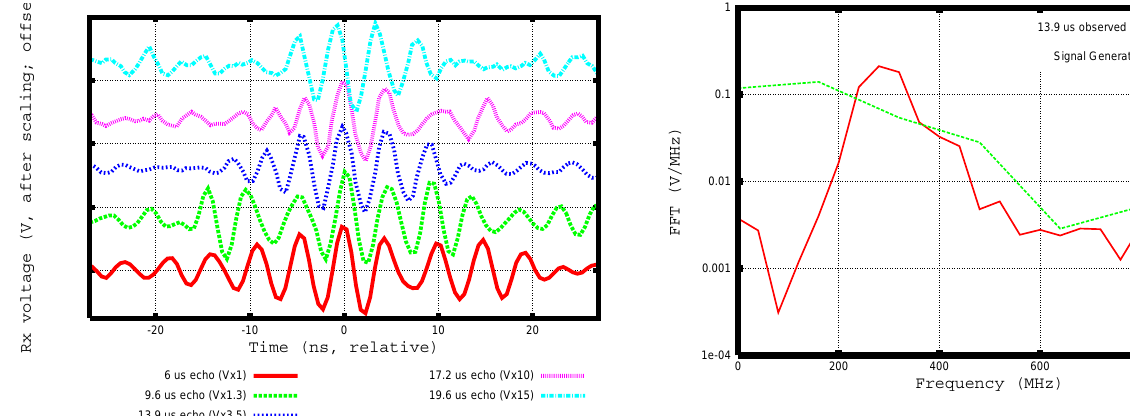
Fig. 8. Overlay of waveforms observed for various echoes. Ampli- tudes have been multiplied by indicated scale factors (in parenthe- ses) to facilitate visual comparison.